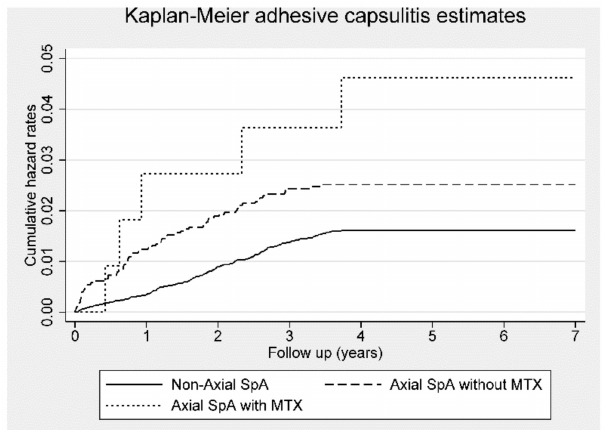
Figure 4. Kaplan–Meier hazard curve for adhesive capsulitis in patients with axial spondyloarthritis (Axial SpA) with or without methotrexate (MTX) use and control subjects over the 7-year follow-up period.